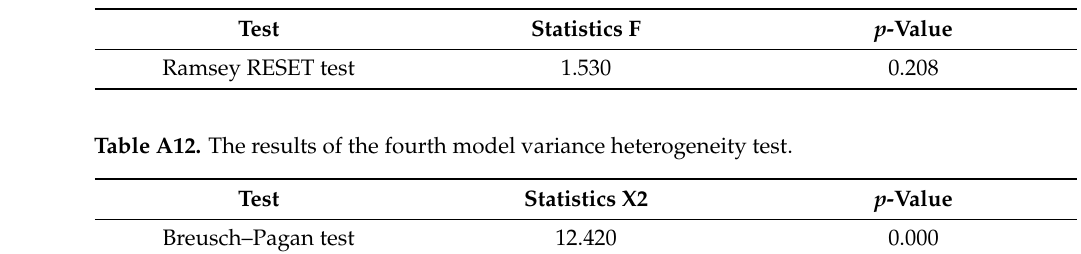
Table A11. The specification test results of the third model.